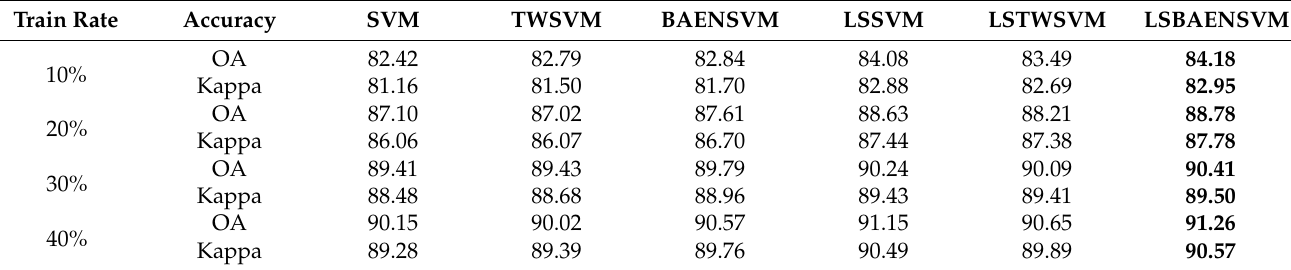
Table 2. Classification results of Indian Pines hyperspectral